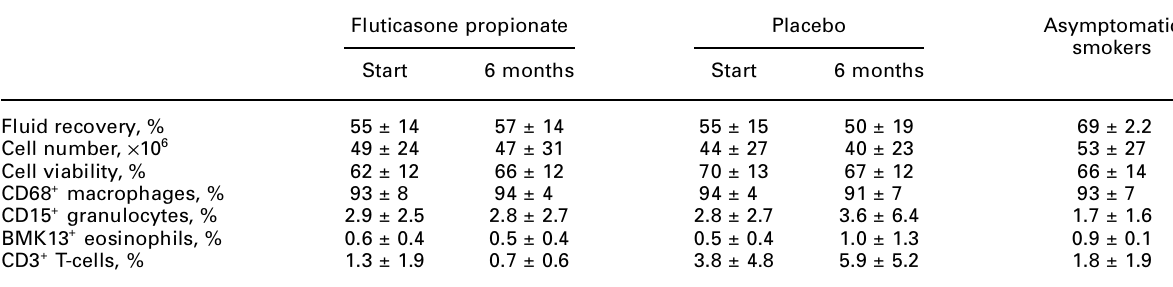
Table 2. Characteristics of bronchoalveolar